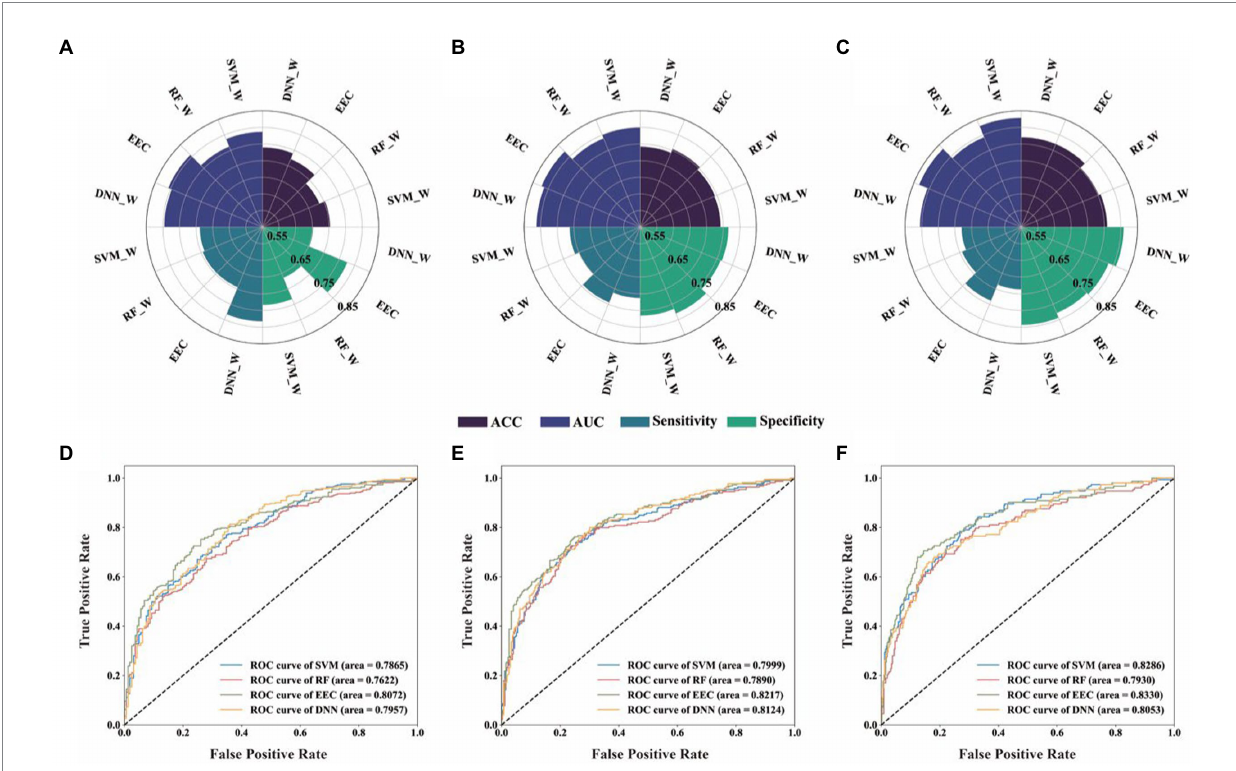
FIGURE 2 Performance of four machine learning models for binary classification of each class defining threshold. (A , D) , Threshold 0.25D, diagnostic values and ROC analysis of the four different predictive model; (B , E) , Threshold 0.5D, diagnostic values and ROC analysis of the four different predictive model; (C , F) , Threshold 0.75D, diagnostic values and ROC analysis of the four different predictive model. SVC_W, SVC algorithm with balancing strategies; RF_W, RF algorithm with balancing strategies; DNN_W, DNN algorithm with balancing strategies. (SVM_W, Support Vector Machine with balance method; RF_W, Random Forest with balance method; DNN_W, Deep Neural Network with balance method; EEC, Easy Ensemble Classifier; ROC curve, receiver operating characteristic curve; ACC, accuracy; AUC, area under the ROC